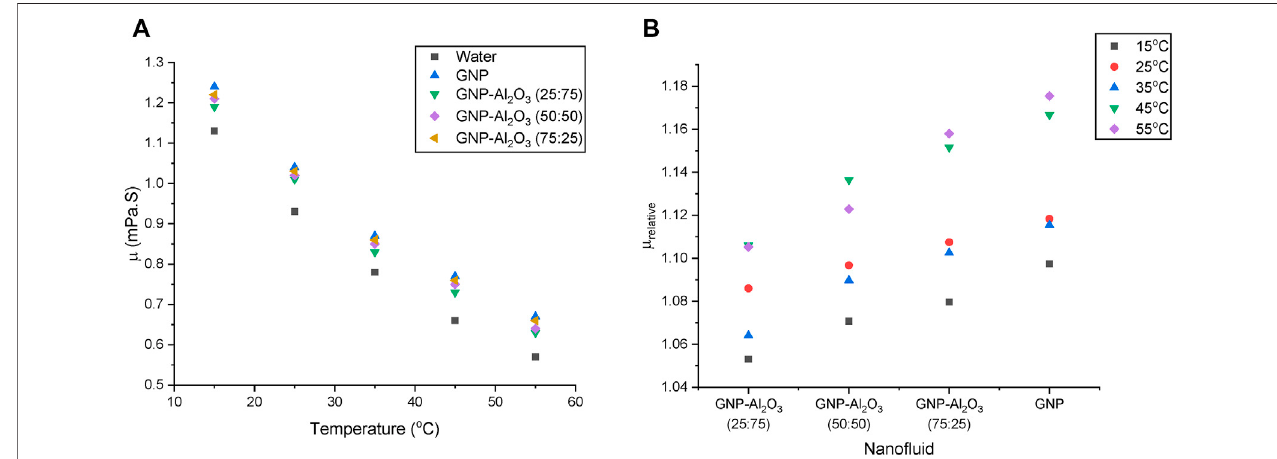
FIGURE 6 | (A) Viscosity and (B) the relative viscosity of the GNP-alumina hybrid nano fl uids for various mixing ratios at different temperatures.